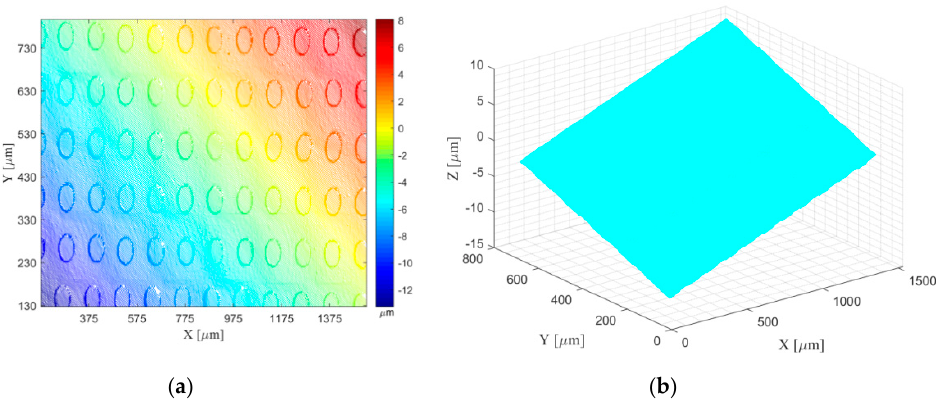
Figure 4. Reconstruction of the surface with trimmed raw data: ( a ) contour plot; ( b ) areal plot.